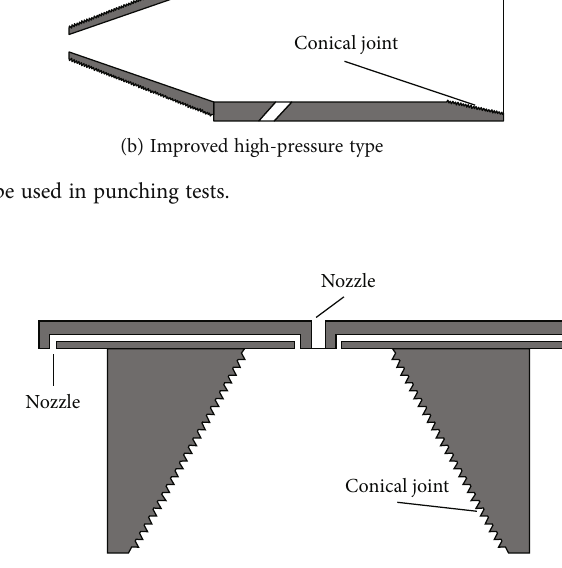
Figure 4: Flow-increasing and cinder-breaking device for conveying cinder.